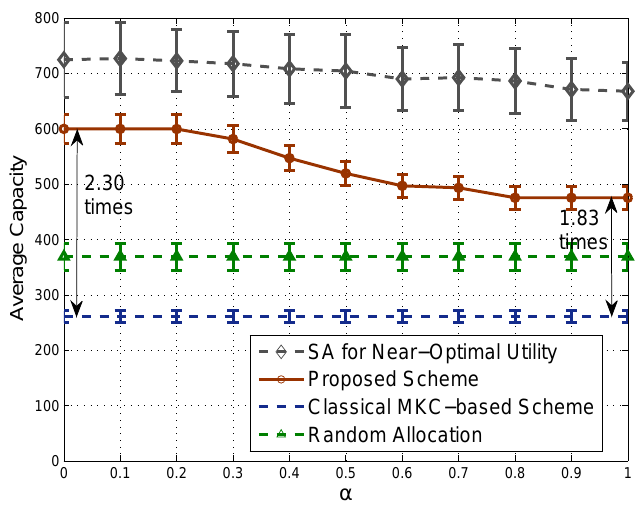
Figure 7. Comparison of average